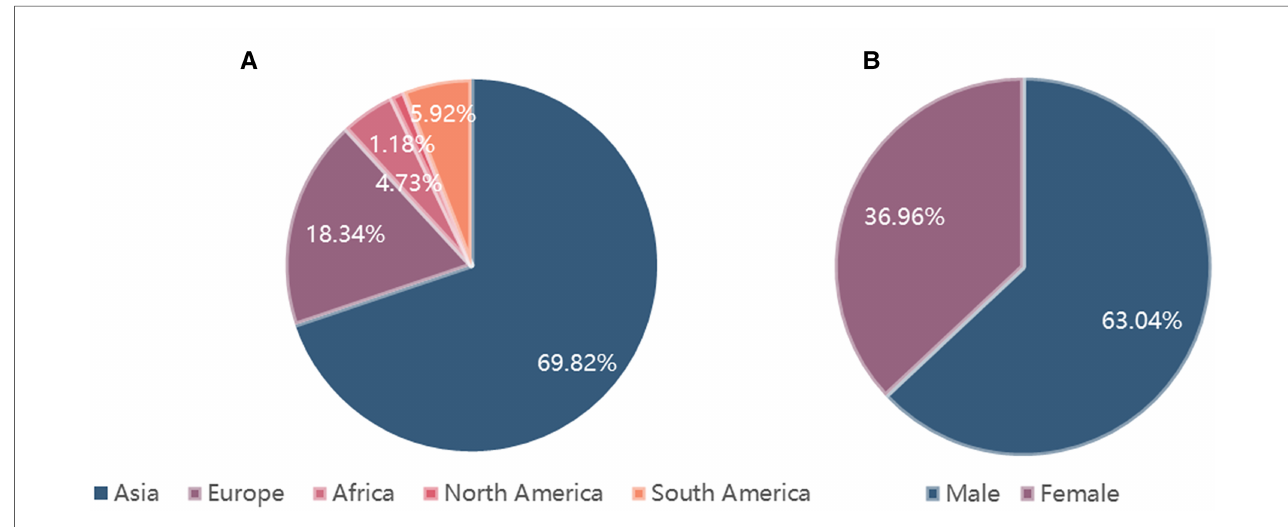
FIGURE 1 The detailed information of geographical country distribution and gender distribution. ( A ). Geographical country distribution; ( B ). Gender